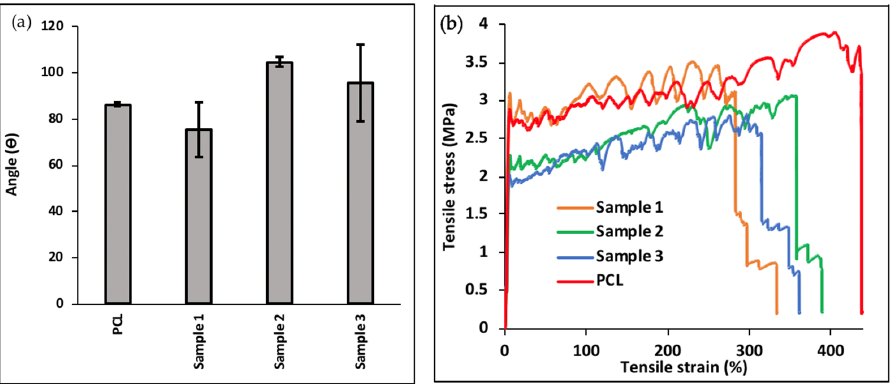
Figure 5. Analysis on 3D ‐ printed samples. ( a ) Water contact angle results of 3D ‐ printed samples and PCL, and ( b ) tensile test.